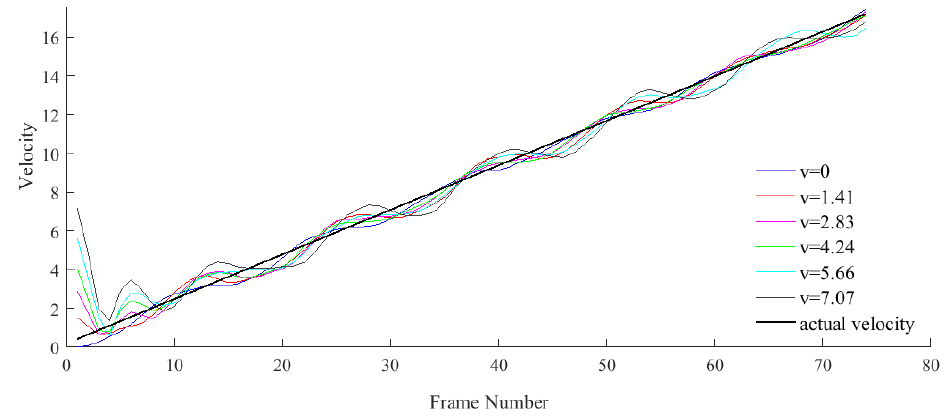
Figure 17. Adaptive velocity adjustment.